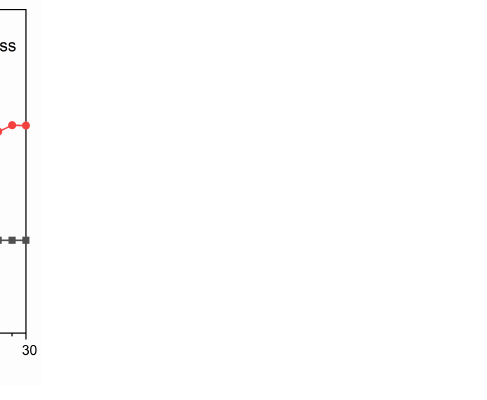
Figure 5. Best fitness and average fitness curves based on the overall randomly segmented dataset.